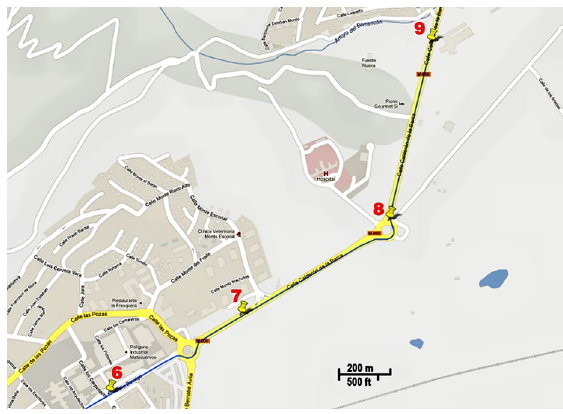
Fig. 10. Urban route between the 6th and 9th minutes, segment between points A and B (image source: Google Maps)